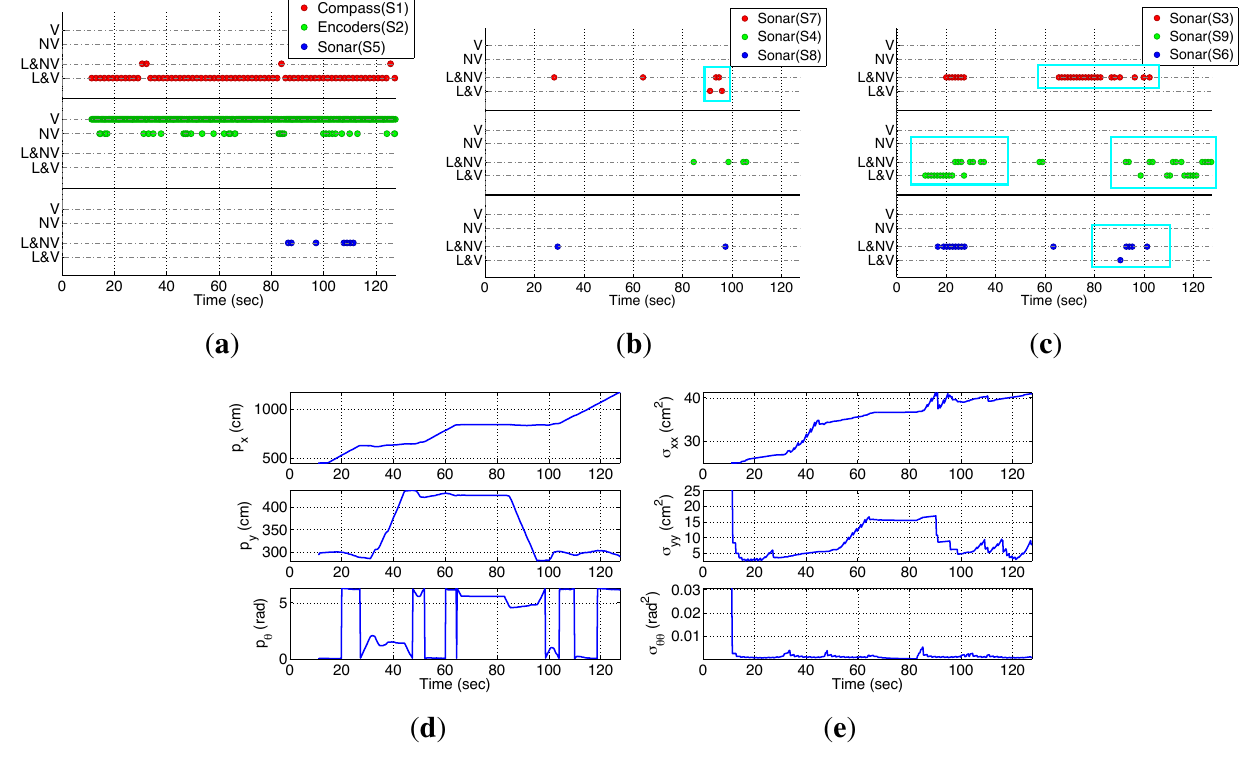
Figure 7. Real Experiments. ( a ) Sensor behavior; ( b ) Sensor behavior; ( c ) Sensor behavior; ( d ) State; ( d )